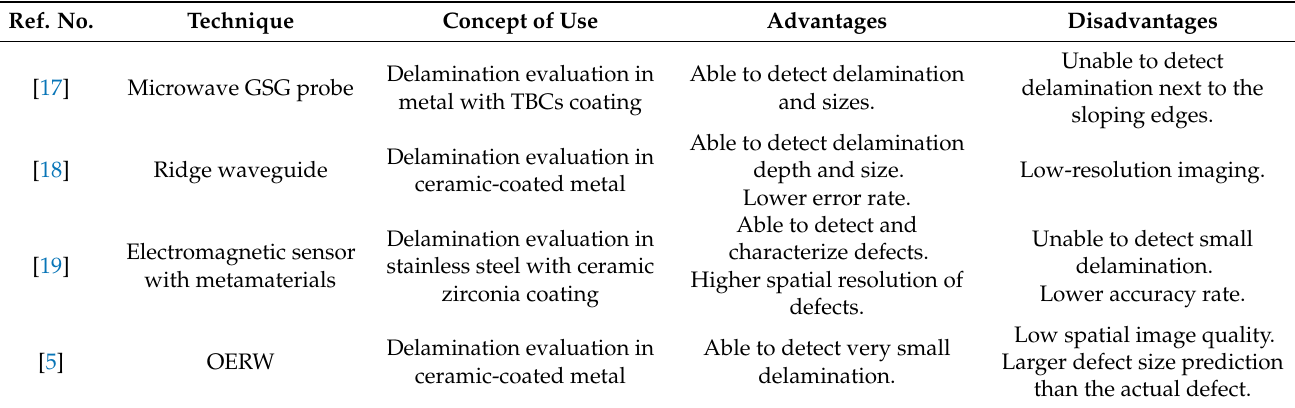
Table 1 summarize the microwave NDT techniques. Table 1. Comparison of microwave NDT